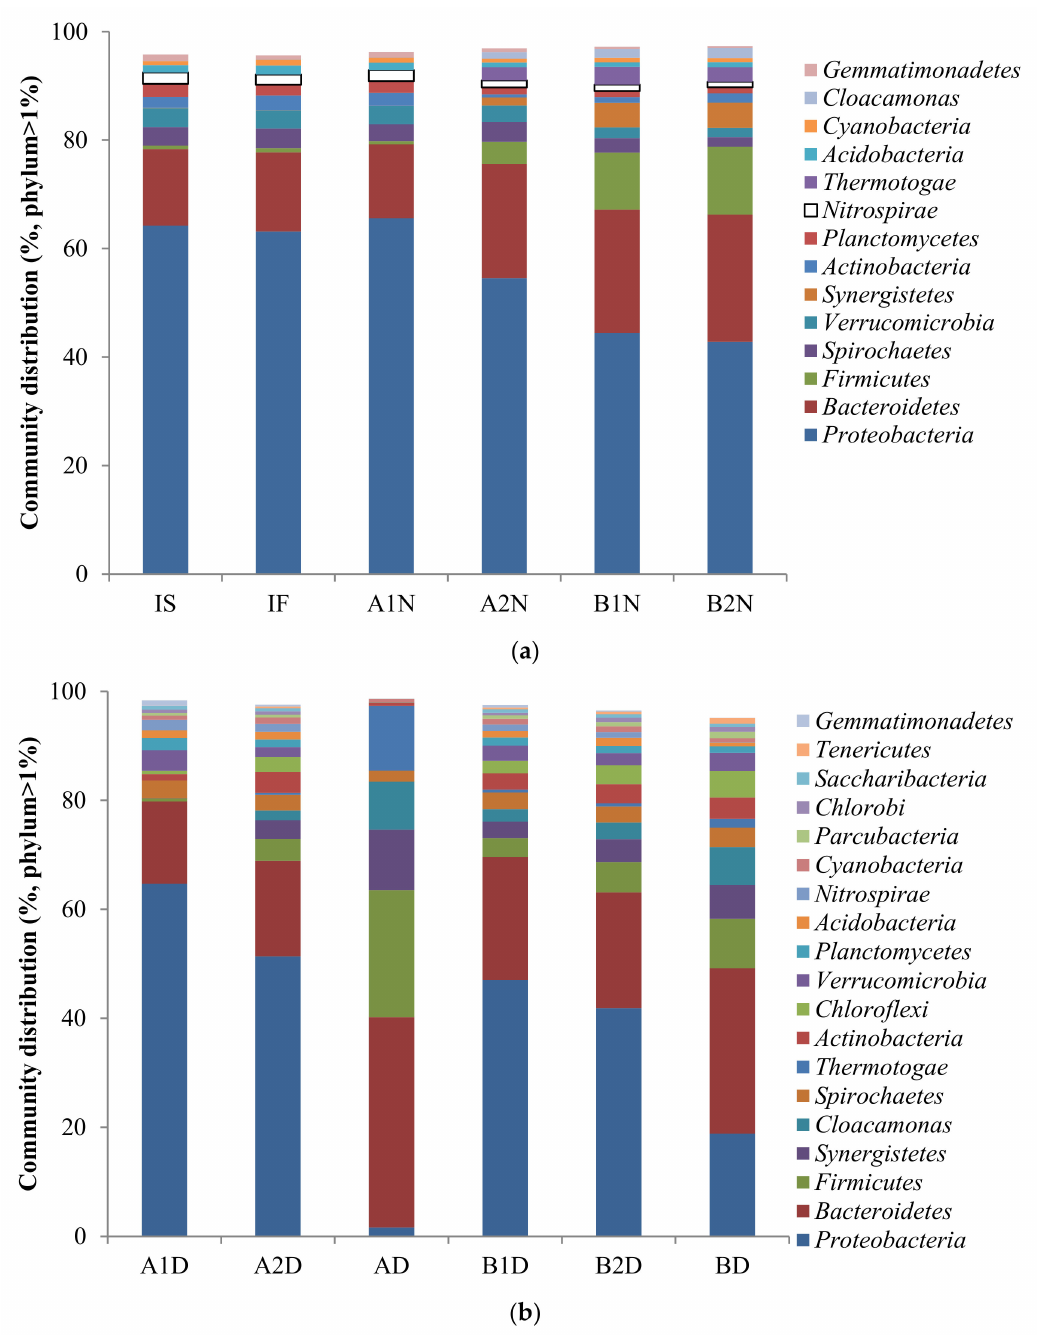
Figure 4. The phylum distribution of microbial communities in ( a ) nitrification and ( b ) denitrification processes of each sample. A and B indicate acetate and butyrate, respectively, and N and D represent nitrification and denitrification, respectively. Initial sludge (IS) microbial communities were compared to those in final nitrification samples